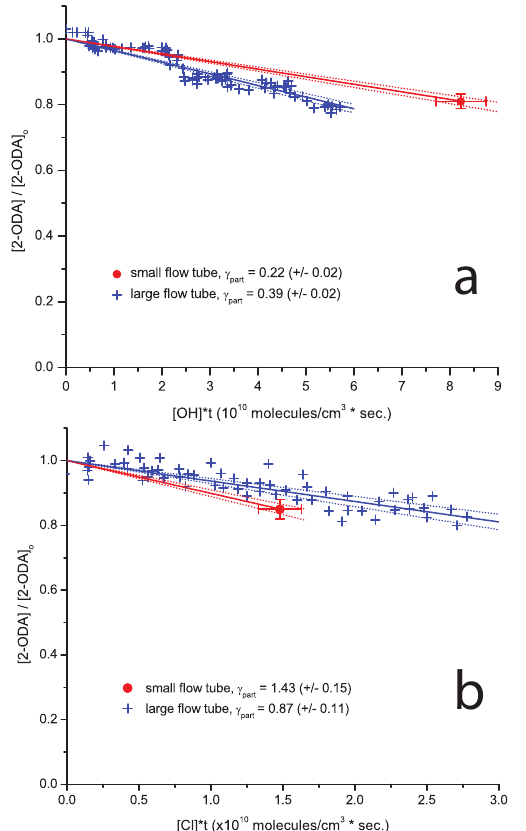
Fig. 2. (a) Sample 2-ODA particle decays from small and large flow tubes. For the examples shown, γ part for OH on 2-ODA parti- cles were 0.22 (50nm particles) and 0.39 (58nm particles) for the small and large flow tubes, respectively. (b) Sample 2-ODA particle decays from small and large flow tubes. For the examples shown, γ part for Cl on 2-ODA particles were 1.43 (52nm particles) and 0.87 (58nm particles) for the small and large flow tubes, respectively. These reactive uptake coefficients were not corrected for limitation of uptake by gas phase diffusion.